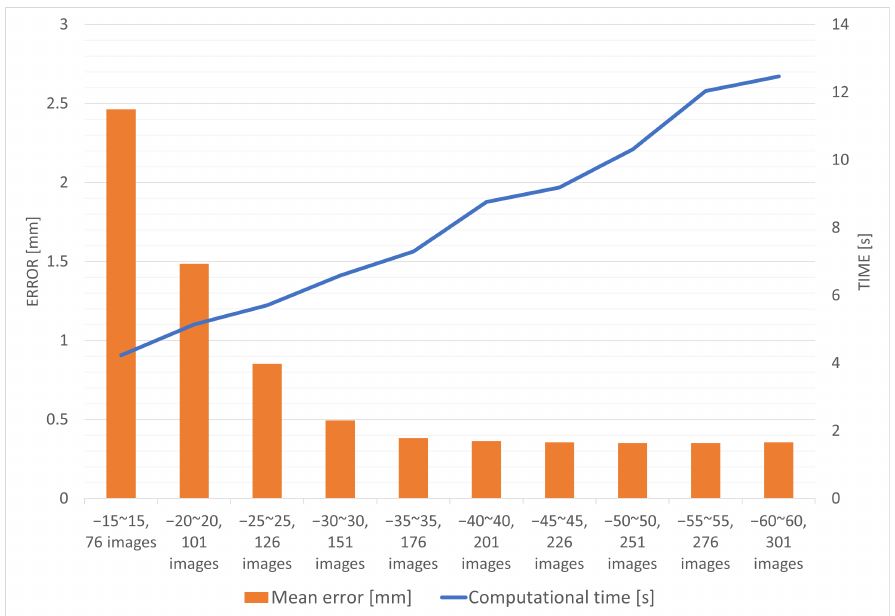
Figure 8. Graph of mean errors (orange bars) and computational time (blue plot) according to different angular ranges applied to the calibration algorithm; the interval of the data is 0.4 degrees for each range. The x-axis represents the angular range of the data applied to the calibration. The y-axis on the left and right give the error and computational time,